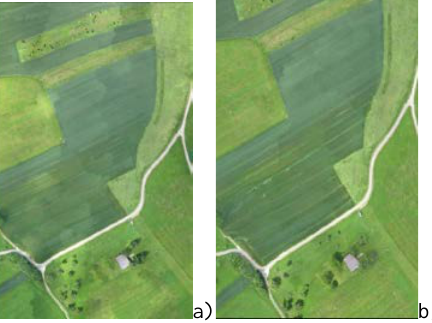
a) b) Figure 4: a) Flight BezF6 area, b) Flight BezF7 area.